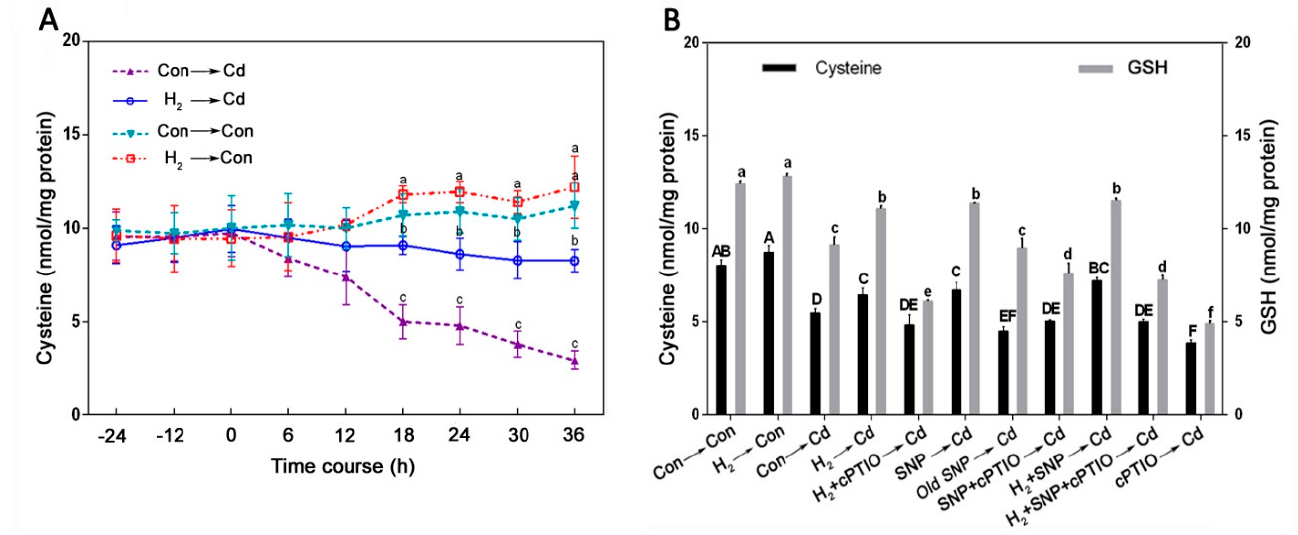
Figure 6. Time course of cysteine (Cys) content under H 2 and Cd treatments and its sensitivity to NO scavenging. Two − day − old mycelia were either pre-treated or not with 3% H 2 for 24 h and then were stressed or not with Cd for 36 h, and the Cys content was quantified at the indicated time points ( A ). Additionally, as shown in B, two − day − old mycelia were either pre-treated or not with H 2 for 24 h and then were stressed or not with Cd for 18 h. Stressed mycelia were either pre-treated or not with 500 μ M SNP, 500 μ M old SNP, or 500 μ M cPTIO alone or in the indicated combinations for 30 min after H 2 treatment. Afterward, Cys ( B ; left) and GSH ( B ; right) contents were measured. Different letters indicate signifi- cant differences between treatments at the indicated time points in A or after 18 h in B according to one-way ANOVA with multiple comparison using Tukey’s test at p < 0.05.